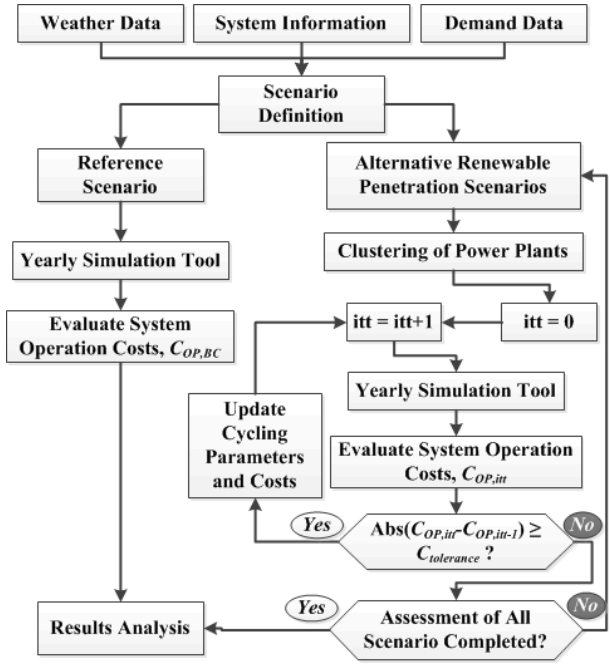
Figure 2. Steps in the proposed methodology.